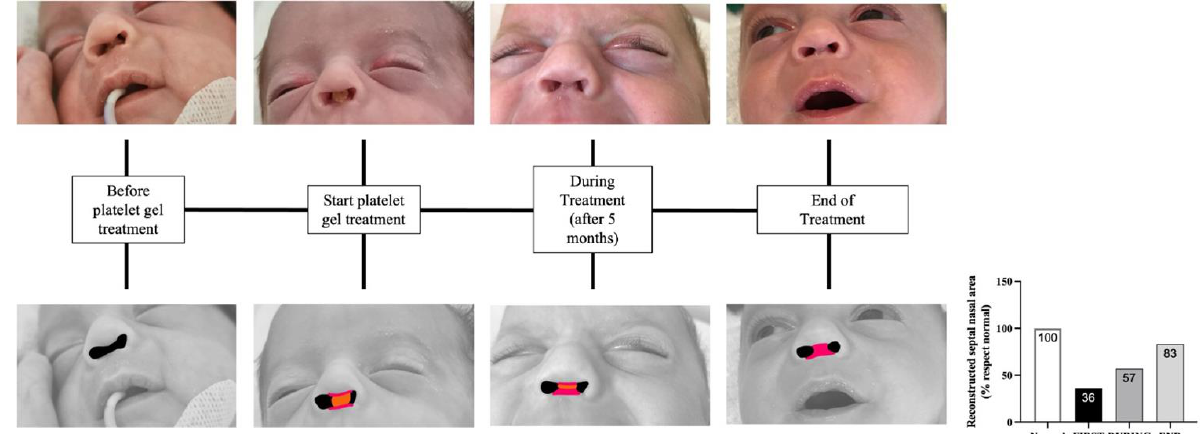
Figure 1. The reconstructed area is portrayed in red in the figure below.